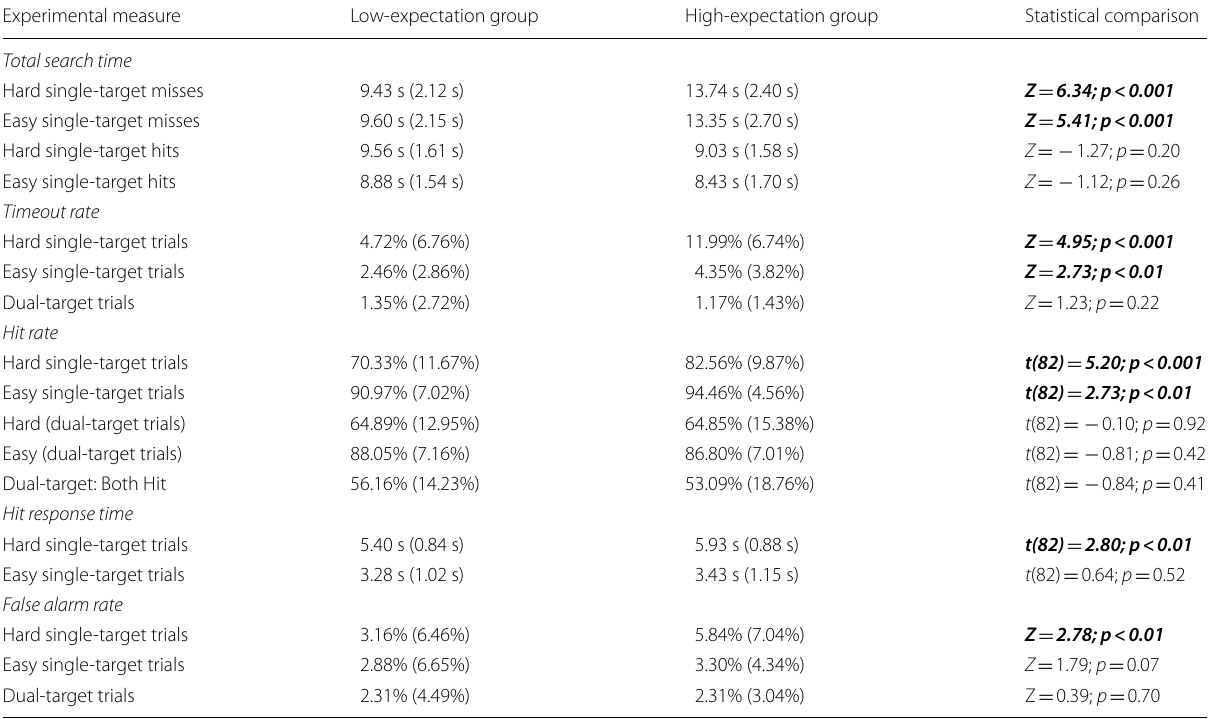
Significant differences between groups are indicated in bold italics